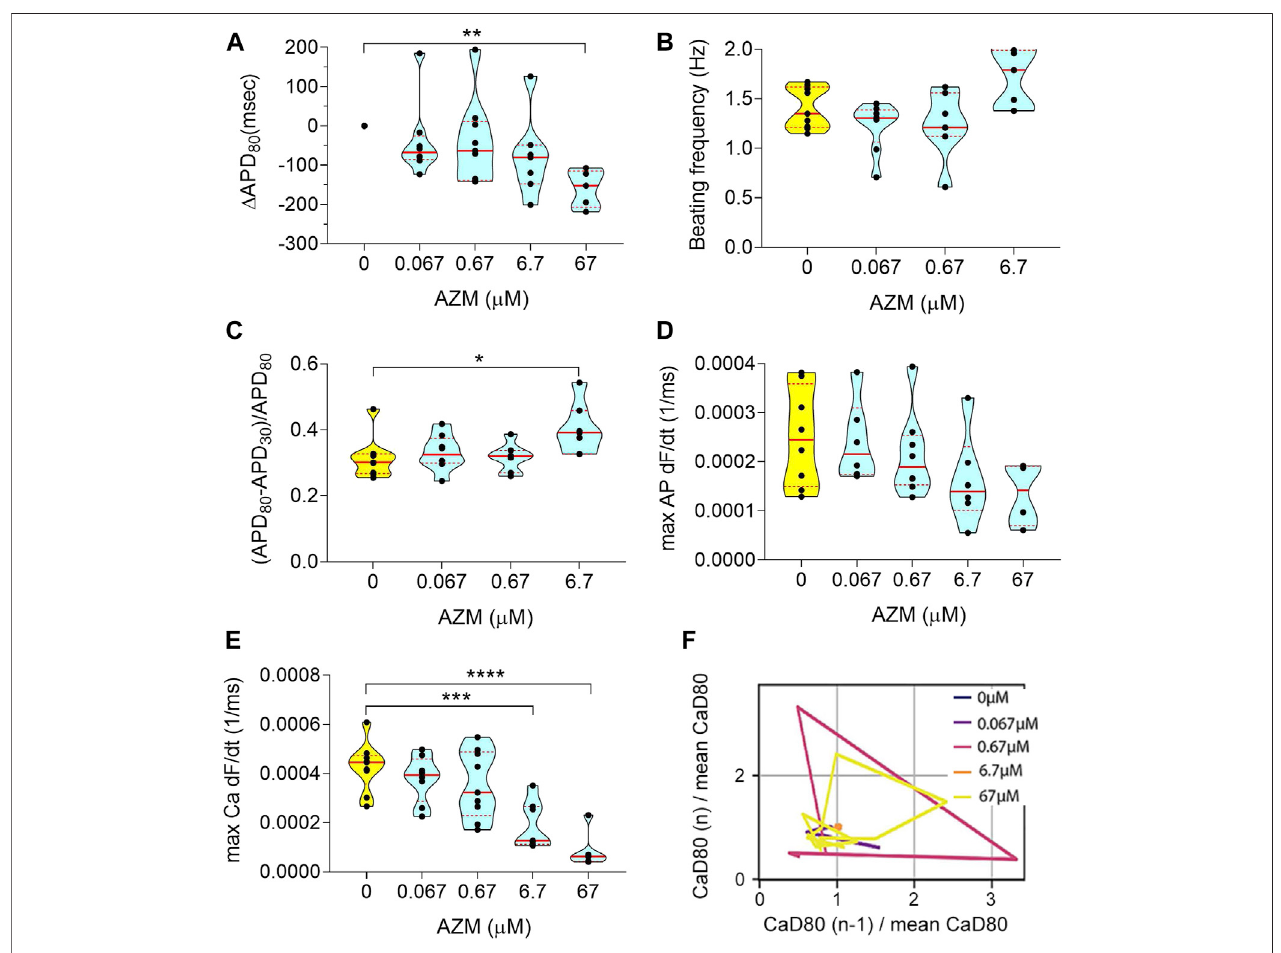
FIGURE 4 | Electrophysiology analysis of acute AZM exposure. (A) Violin plot depicting the change in APD 80 in paced tissues over increasing doses. Values were normalizedtobaseline0 μ Mofeach tissue chamber. (B) Graphshowingspontaneous beatingfrequencyinHz,forupto6.7 μ MAZM.At67 μ Mtissuesstoppedbeating spontaneouly and data was therefore excluded from the graph. (C) Change in triangulation ofspontaneousaction potential traces. The 67 μ M data wasnot shown, due to ceaseof spontaneous beatingactivity. (D) Violin plot showing the action potential maximum upstrokevelocity,calculated asthemaximum oftheupstroke slope ofpacedtraces. (E) Graphdescribing themaximumupstrokevelocityofpacedcalciumtransienttraces. (F) RepresentativePoincaréplotshowinginstabilities incalcium transientdurationinresponsetoincreasingAZM doses(datafromspontaneous traces).AlltissuesanalyzedwerewithininclusioncriteriaofAPD 80 < 500msat baseline. Statistics run were one-way ANOVA with multiple comparison to baseline 0 μ M and Dunnett ’ s post-hoc correction. * p < 0.05; ** p < 0.01; *** p < 0.001, **** p < 0.0001.